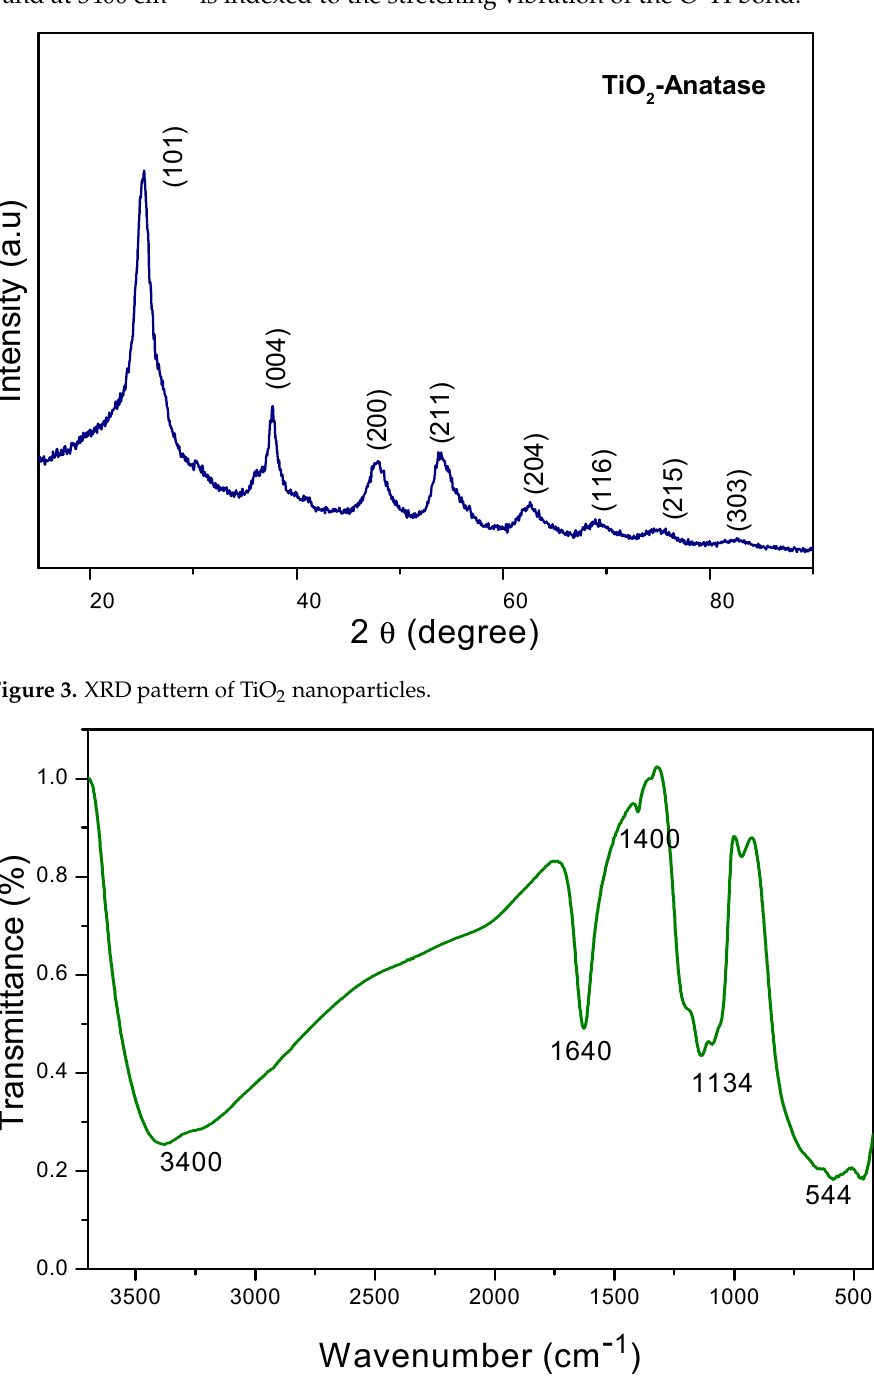
Figure 5. UV/visible spectrum of TiO 2 nanoparticles. The nanoparticle-like morphology of TiO 2 was measured using transmission electron microscopy, as shown in Figure6. The average diameter of nanoparticles was 10–15 nm.